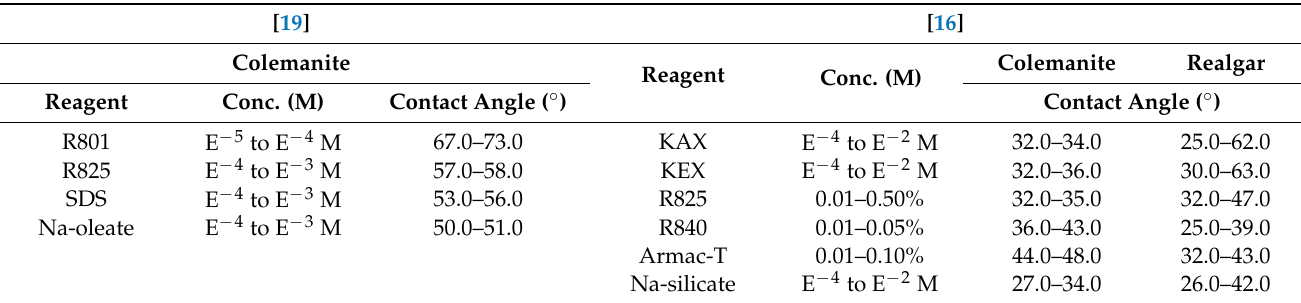
Table 4. Effects of anionic reagents on colemanite and realgar contact angles at pH 9 [16,19].